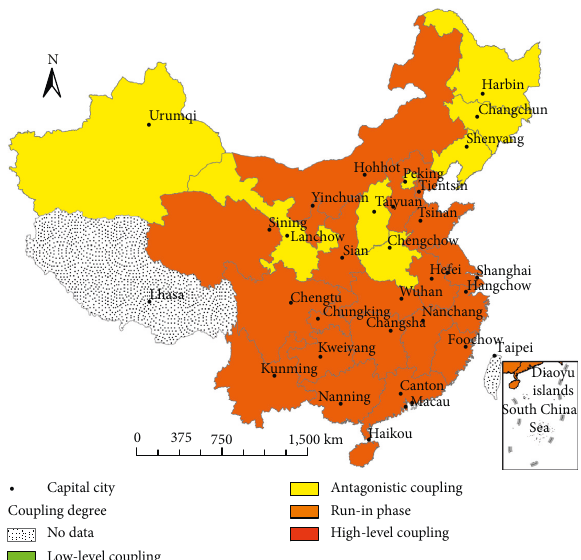
Figure 3: Spatial differentiation of the urban human settlements system’s coupling degree in provincial